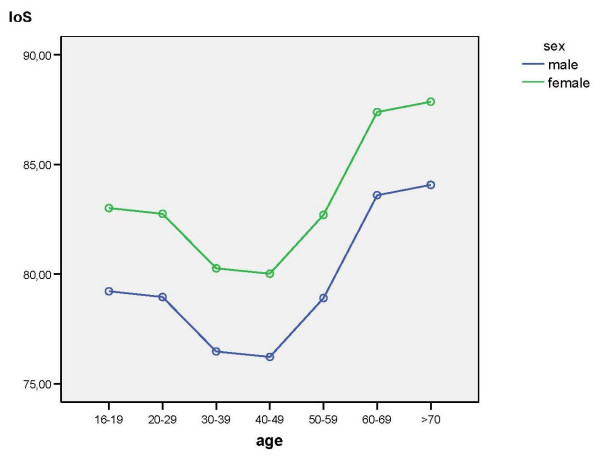
Results of the multifactorial analysis with the effects of age and gender on IoS.